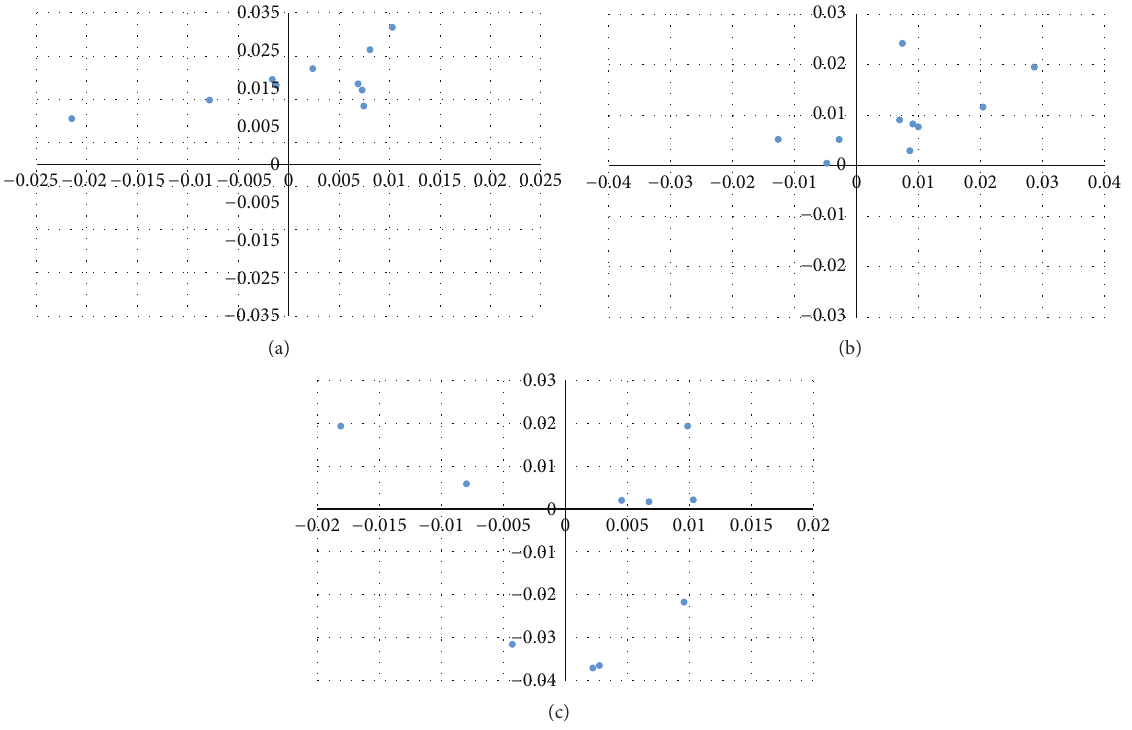
developed method reaches up to 99%. The contrast results between the HSL and RGB color representation